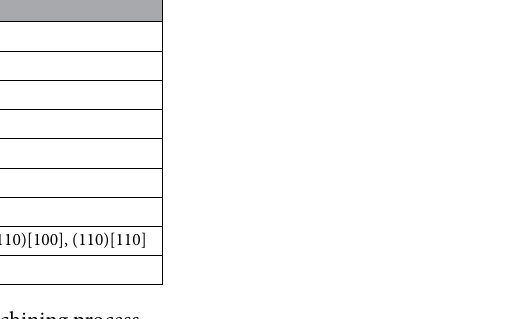
Table 1. Parameters of simulation in the machining